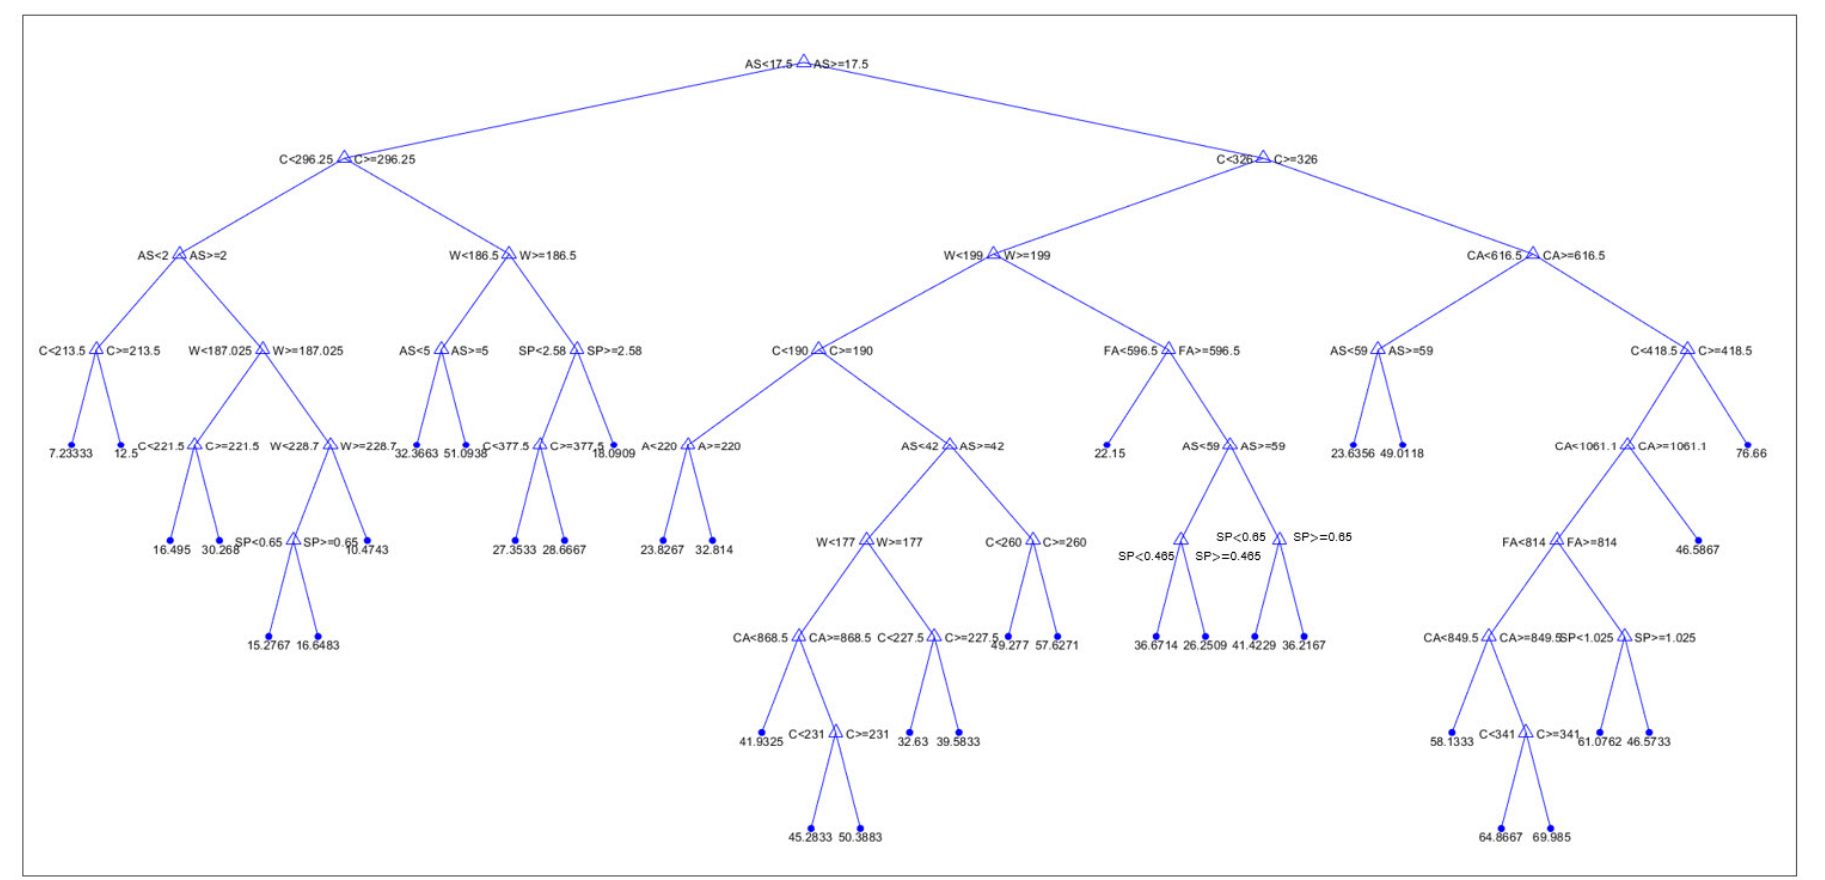
Figure A1. Optimal individual model based on regression trees.